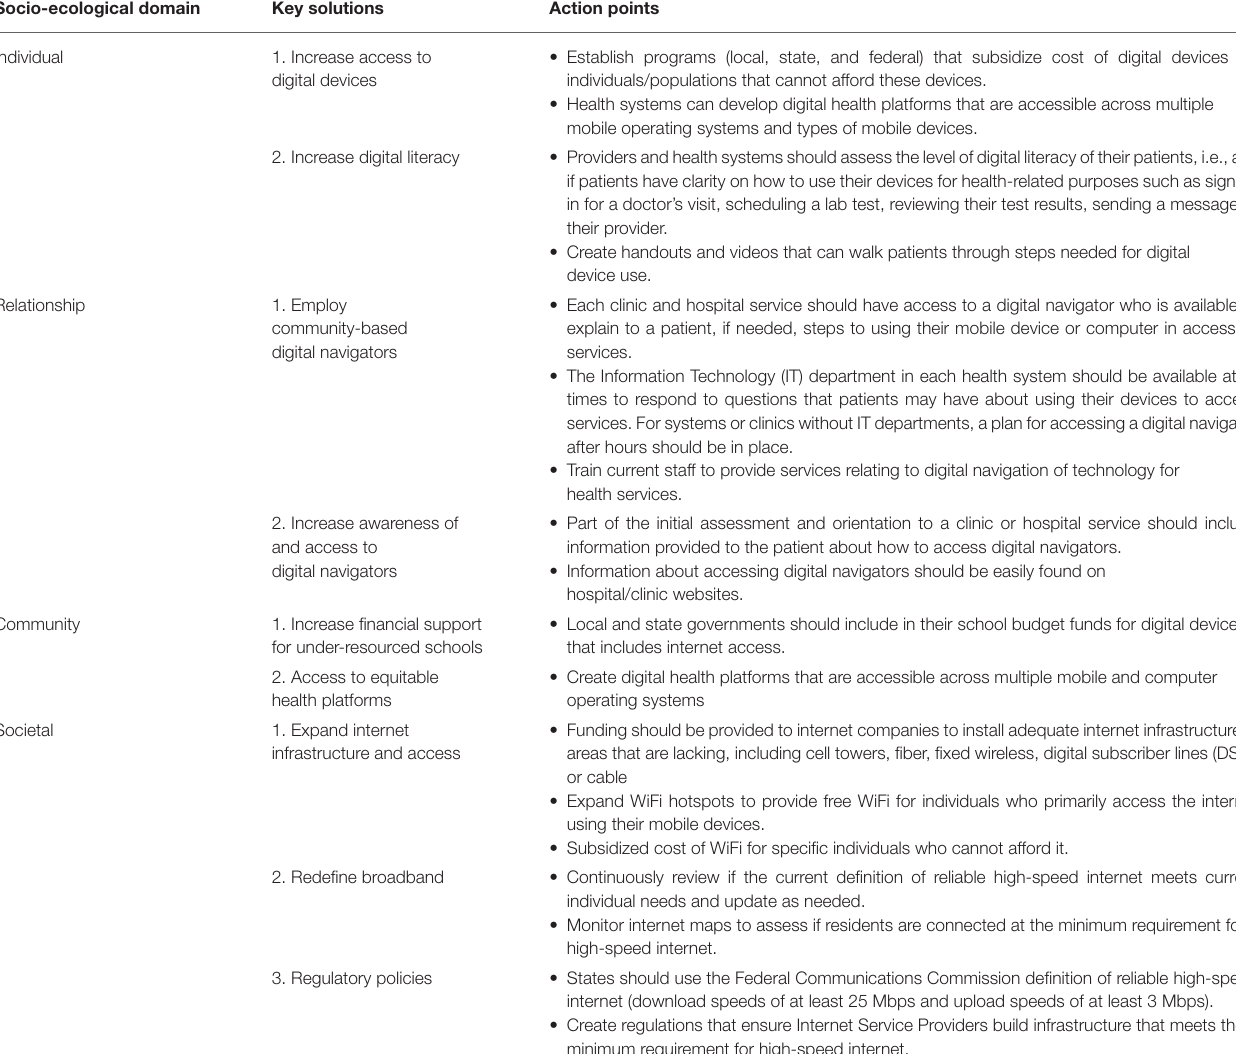
TABLE 1 | Key solutions and action points for addressing digital redlining. Socio-ecological